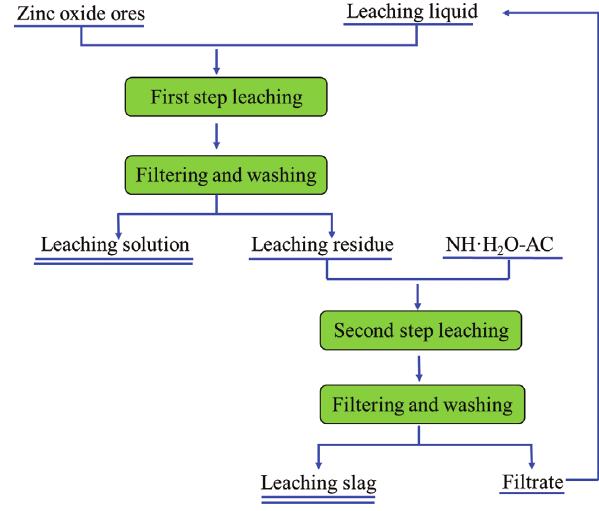
Figure 2: Flow diagram of the leaching process.